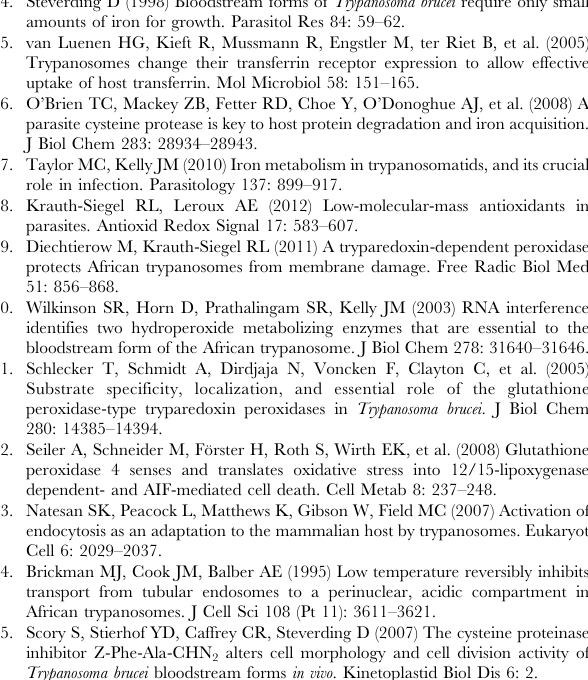
from lysis. The mutant cells were incubated in standard DIDS. The data represent the mean 6 SD of three independent experiments. Figure S4 Supplementing the medium with hemoglobin slightly induces lysis of the px I–II 2 / 2 BS parasites. Cells